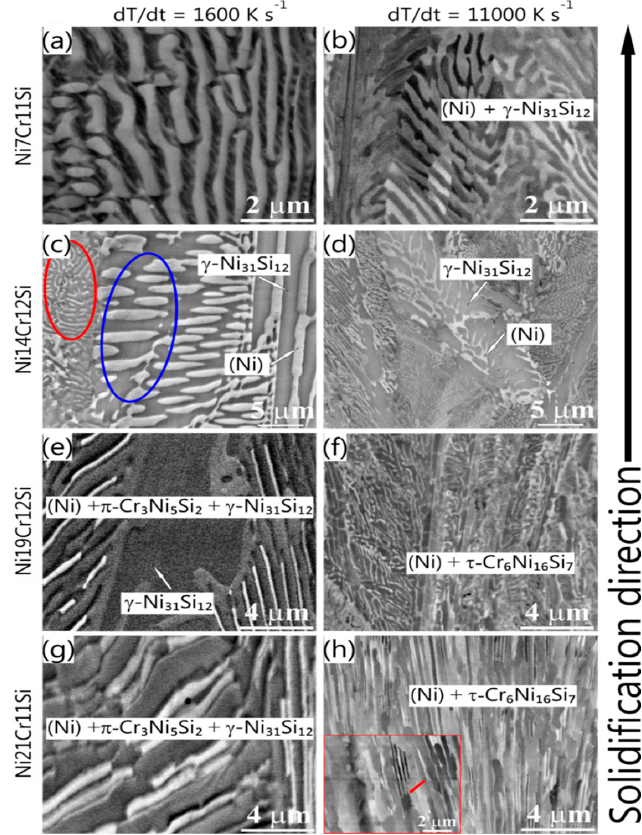
Figure 5. BSE micrographs of each rapidly solidified alloy, i.e., ( a , b ): Ni7Cr11Si; ( c , d ): Ni14Cr12Si; ( e , f ): Ni19Cr12Si; ( g , h ): Ni21Cr11Si. The microstructures on the left and right columns are obtained at a cooling rate of 1600 K s − 1 and 11000 K s − 1 , respectively.